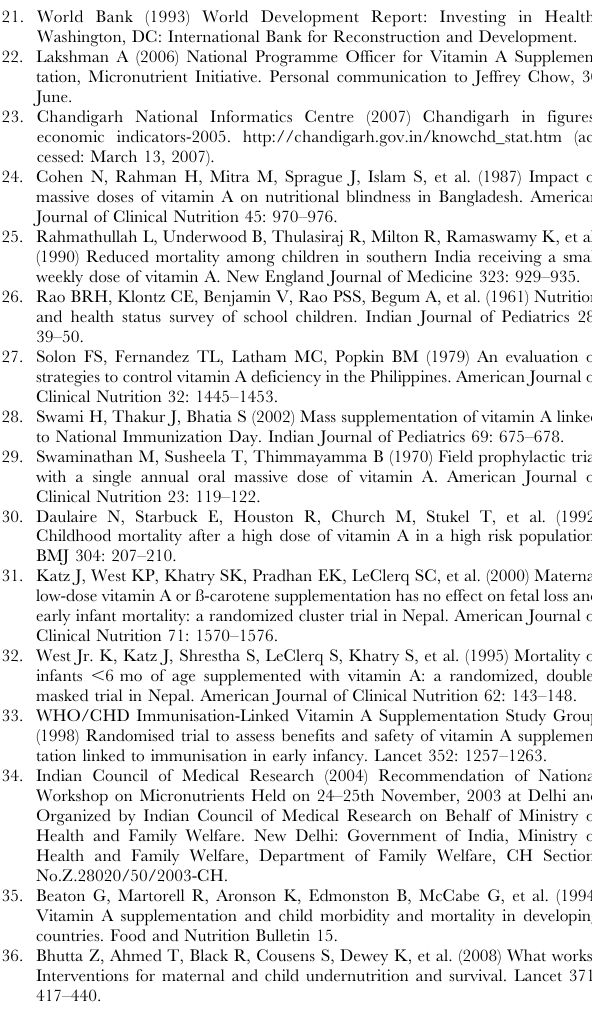
Table S2 State-specific cost-effectiveness calculations ( $ /DALY